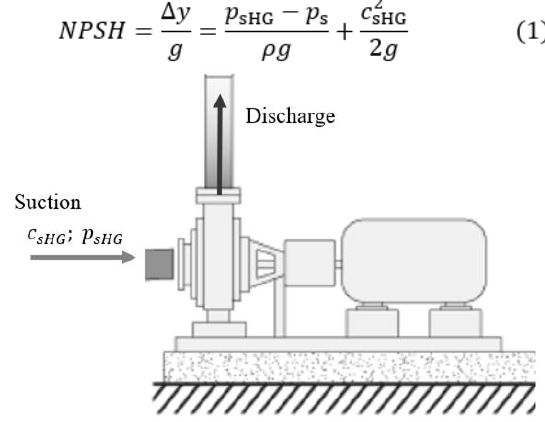
Fig. 5. Cavitation erosion